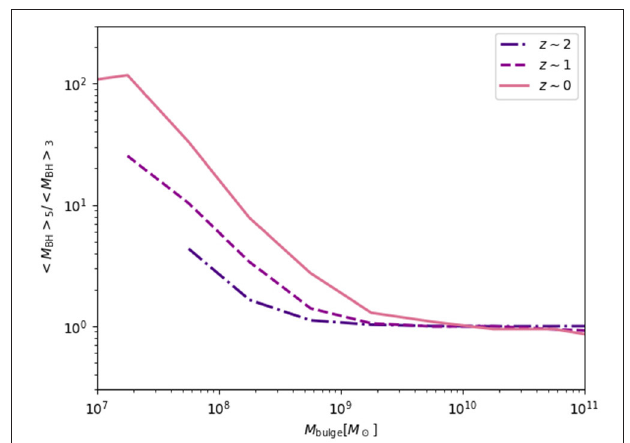
FIGURE 2 | The difference of averaged SMBH mass due to the seed BH mass at z ∼ 2 (dash-doted line in blue), z ∼ 1 (dashed line in purple), and z ∼ 0 (solid line in pink) as a function of their bulge stellar mass with the ν 2 GC -H2 simulation. The difference becomes smaller at higher redshift.